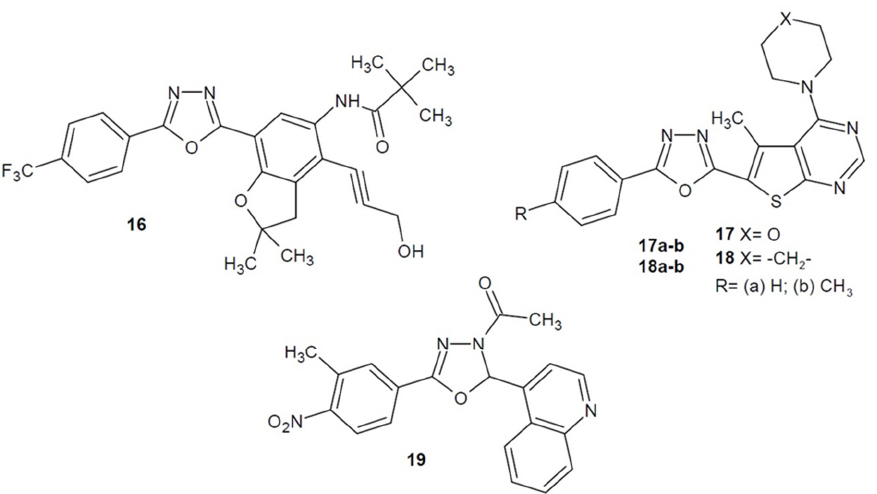
Figure 8. Aryl and/or heteroaryl 1,3,4-oxadiazole derivatives with antibacterial activity (part 4).